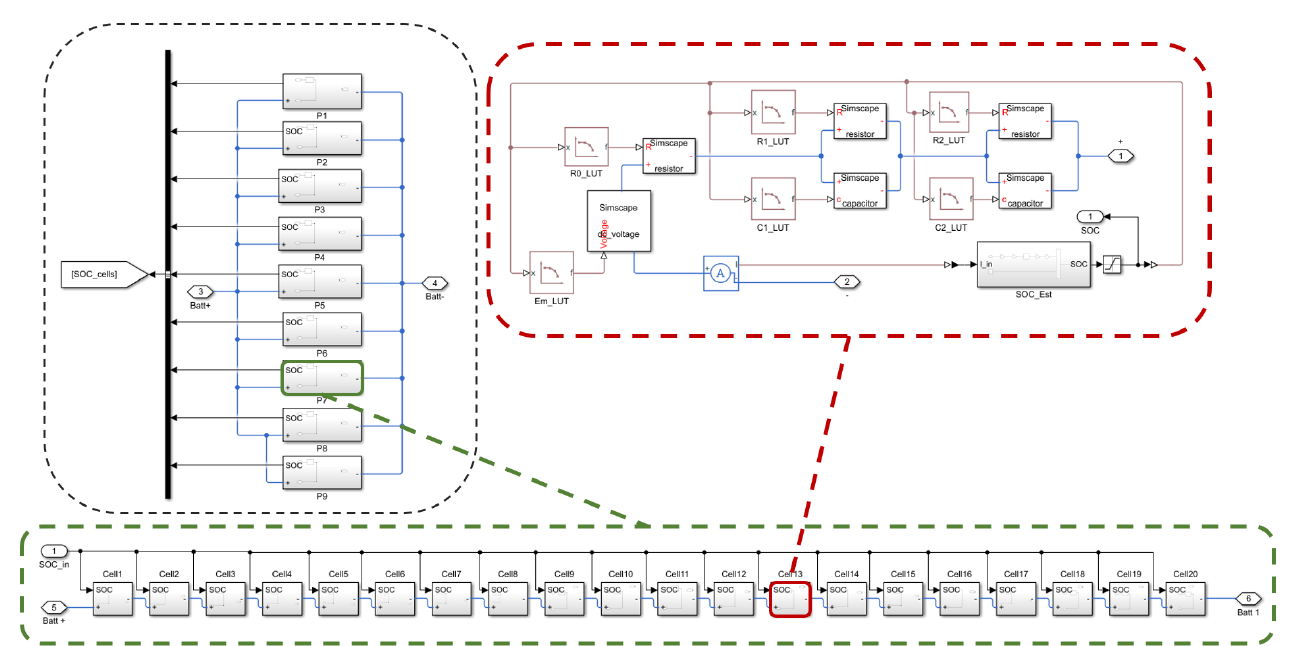
Figure 5. Model of the battery pack configuration on Simulink virtual